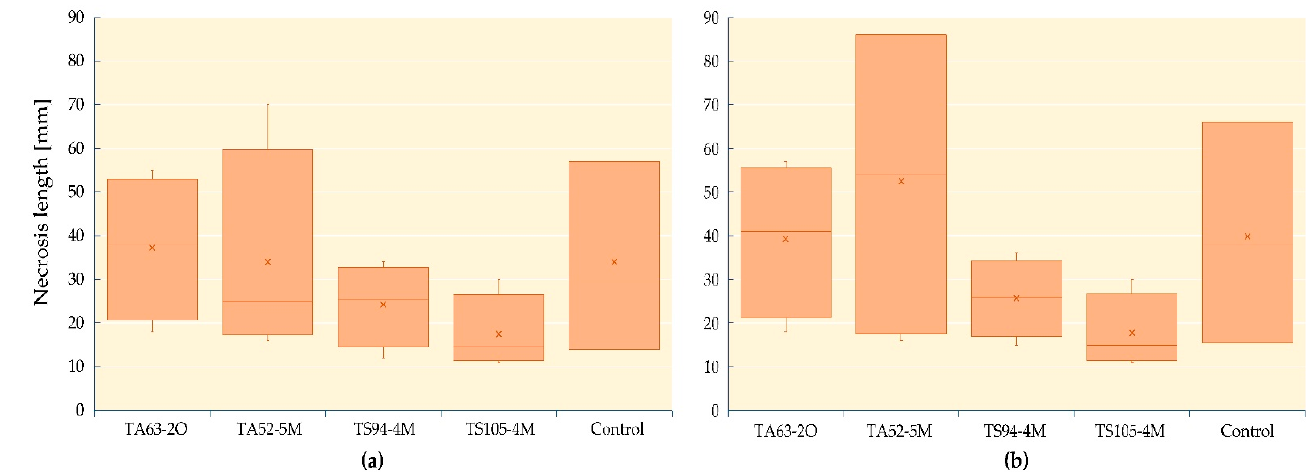
Figure 6. Box and whisker plots showing the length of superficial ( a ) and cambial ( b ) necroses developed by artificially inoculated Hymenoscyphus fraxineus on the bark of ash trees colonized or not colonized (control) by selected endophytic fungal isolates (TA63-2O— Didymella macrostoma , TA52-5M— Dothiorella gregaria , TS94-4M— Fusarium lateritium , TS105-4M— Didymella aliena ).